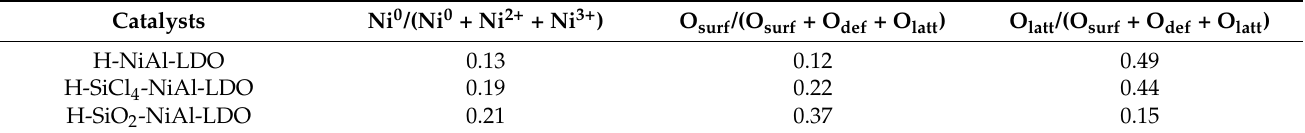
Table 2. Quantification of the metallic Ni and oxygen species of the prepared